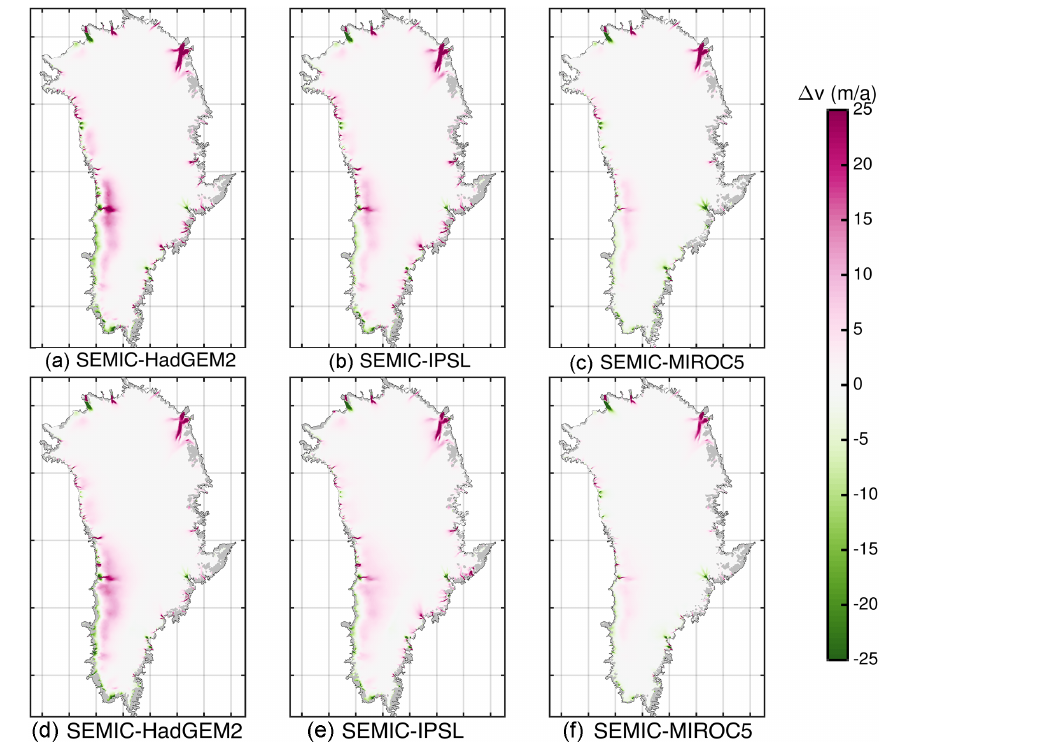
Figure 14. Comparison of multi-year mean surface velocity ( v ) differences under RCP2.6 forcing between 2100–2000 (a–c) and 2300– 2000 (d–f) for (a, d) SEMIC-HadGEM2, (b, e) SEMIC-IPSL, and (c, f) SEMIC-MIROC5. The black contour line depicts the present-day ice mask. Positive values represent glacier acceleration, and negative values deceleration. The data are clipped at an ice thickness of 10m (gray shaded